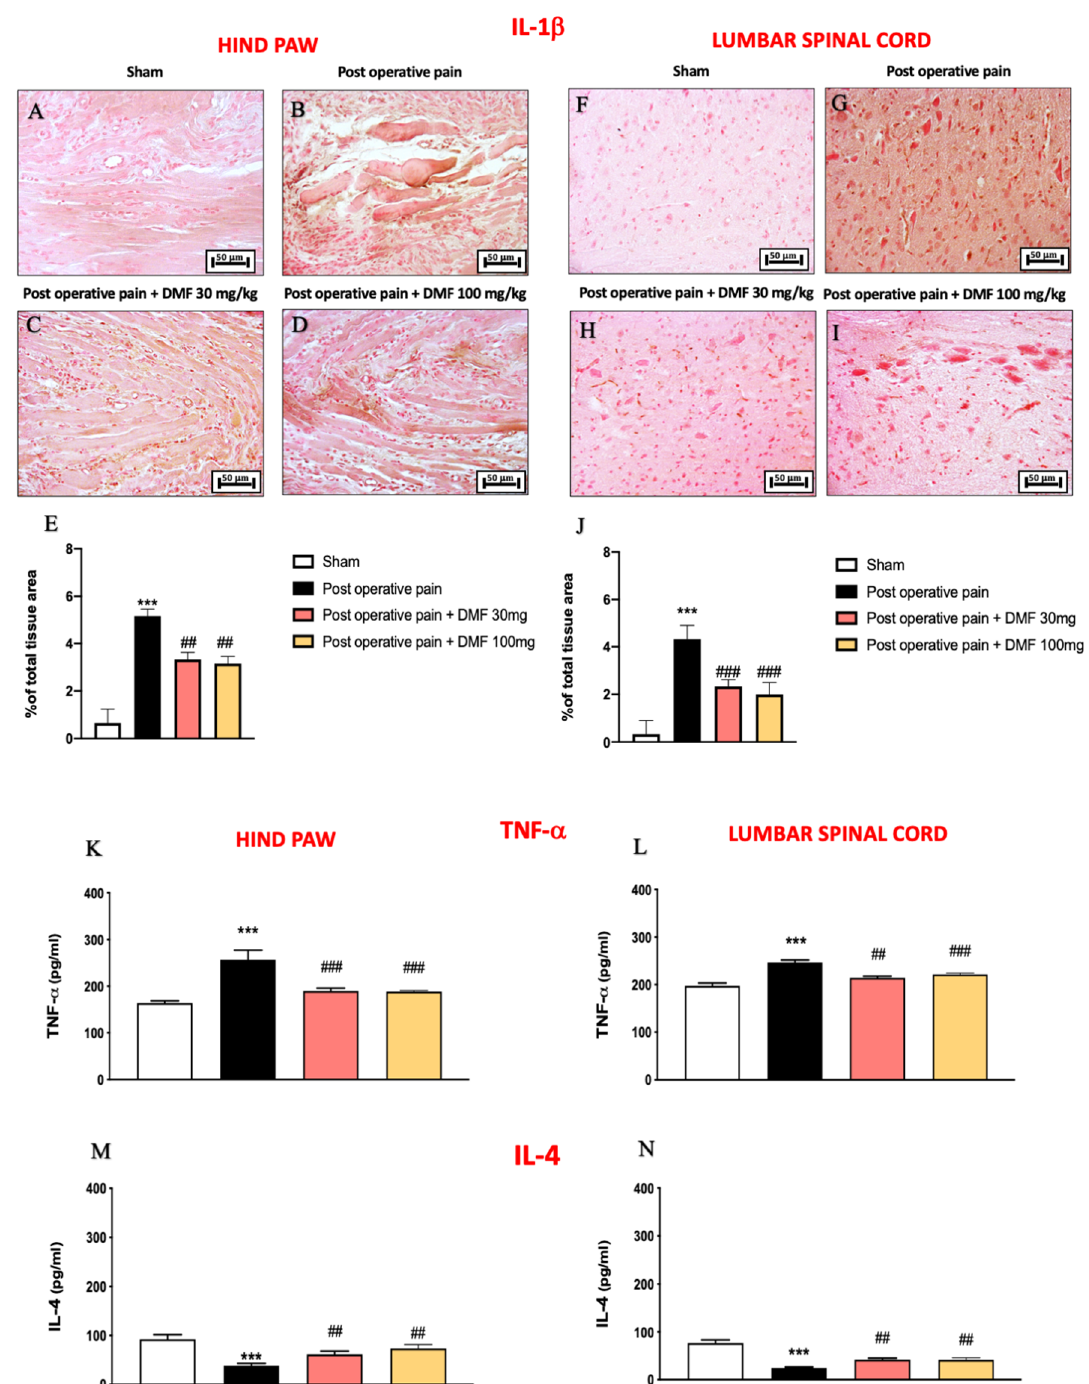
Figure 4. DMF treatment reduced cytokines. Immunohistochemical analysis for IL-1 β on hind paw tissue: sham ( A ), PO pain ( B ), DMF 30 mg/kg ( C ), DMF 100 mg/kg ( D ), score ( E ). Immunohisto- chemical analysis for IL-1 β on lumbar spinal cord tissue: sham ( F ), PO pain ( G ), DMF 30 mg/kg ( H ), DMF 100 mg/kg ( I ), score ( J ). Elisa kit for TNF- α ( K , L ) and IL-4 ( M , N ). A p -value of less than 0.05 was considered significant; *** p < 0.001 vs. sham, ### p < 0.001 and ## p < 0.01 vs. PO pain.